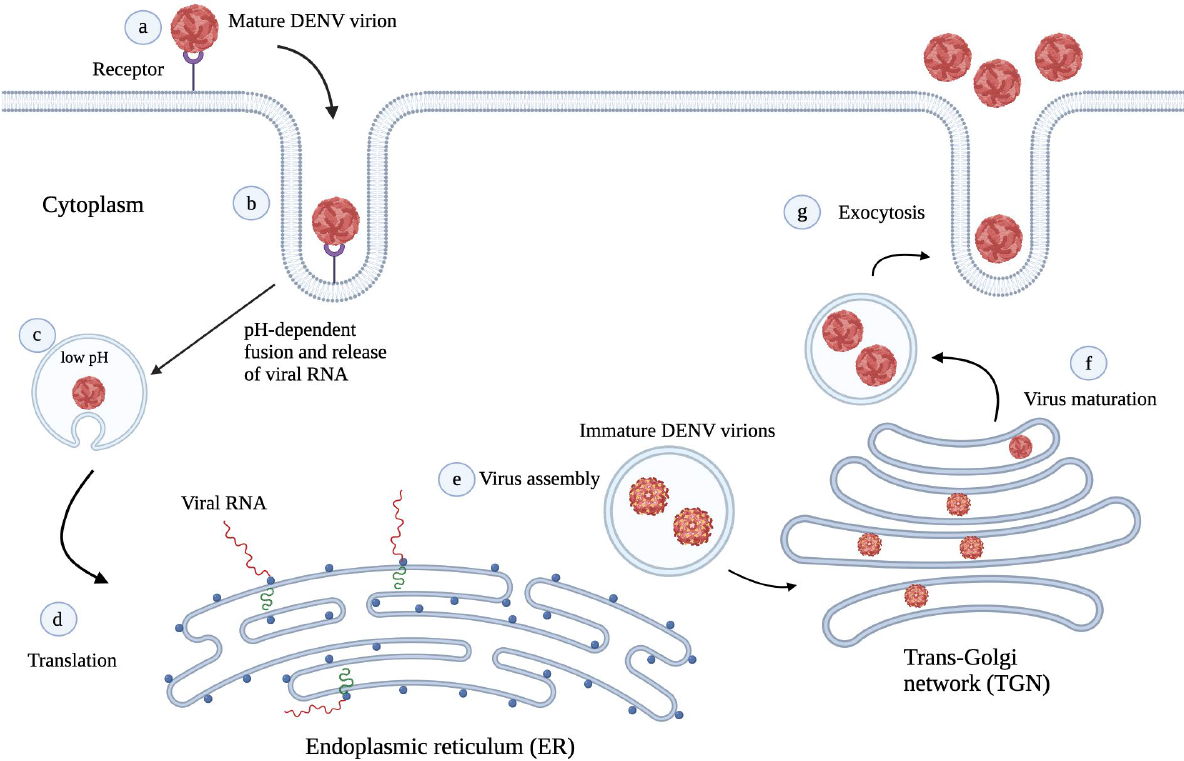
Figure 2. DENV life cycle. ( a ) DENV viral particles attach to the host cells via interactions between DENV surface proteins and their respective host receptors. ( b ) DENV enters host cells via receptor- mediated or clathrin-dependent endocytosis. ( c ) pH-dependent membrane fusion occurs in the en- dosome and this results in the formation of pores which allows the release of the DENV viral ge- nome into the host cytoplasm. ( d ) The released viral RNA is translated into a polyprotein in the host cytoplasm. ( e ) Viral assembly takes place at the ER to form immature DENV virions. ( f ) These im- mature DENV particles travel through the secretory pathway and TGN to form mature DENV viri- ons. ( g ) Following successful virus maturation, the mature DENV particles are then exocytosed from the host cells. The figure was created using Biorender.com (accessed on 7 March 2023). 4. Preclinical and Clinical Status of DENV Antivirals Currently, there are no animal models which can reproduce the same symptoms or clinical manifestations of dengue infections as observed in humans. Various non-human primate models such as rhesus macaques, bonnet monkeys, olive baboons, and African green monkeys have been used for the development of vaccines or antibody-based thera- pies against dengue [46]. However, antiviral drugs are seldom evaluated in these non- human primate models due to issues such as high production costs, difficulty in breeding large numbers of animals, and the absence of severe dengue symptoms mirroring that in humans. On the other hand, murine models such as AG129 mice, BALB/c mice, and C57BL/6 mice have been widely used for the evaluation of in vivo antiviral drug efficacy against DENV. Wild-type immunocompetent murine models such as BALB/c mice and C57BL/6 mice pose various limitations including low systemic infections and the lack of severe dengue symptoms mirroring that in humans. AG129 mice which are deficient in IFN- α / β and γ receptors are more commonly used for antiviral drug testing against DENV, although they also exhibit a lack of severe dengue symptoms mirroring that observed in humans [47,48]. The use of mouse-adapted DENV and non-mouse adapted DENV strains which cause high virulence in AG129 mice had resulted in disease manifestations similar to